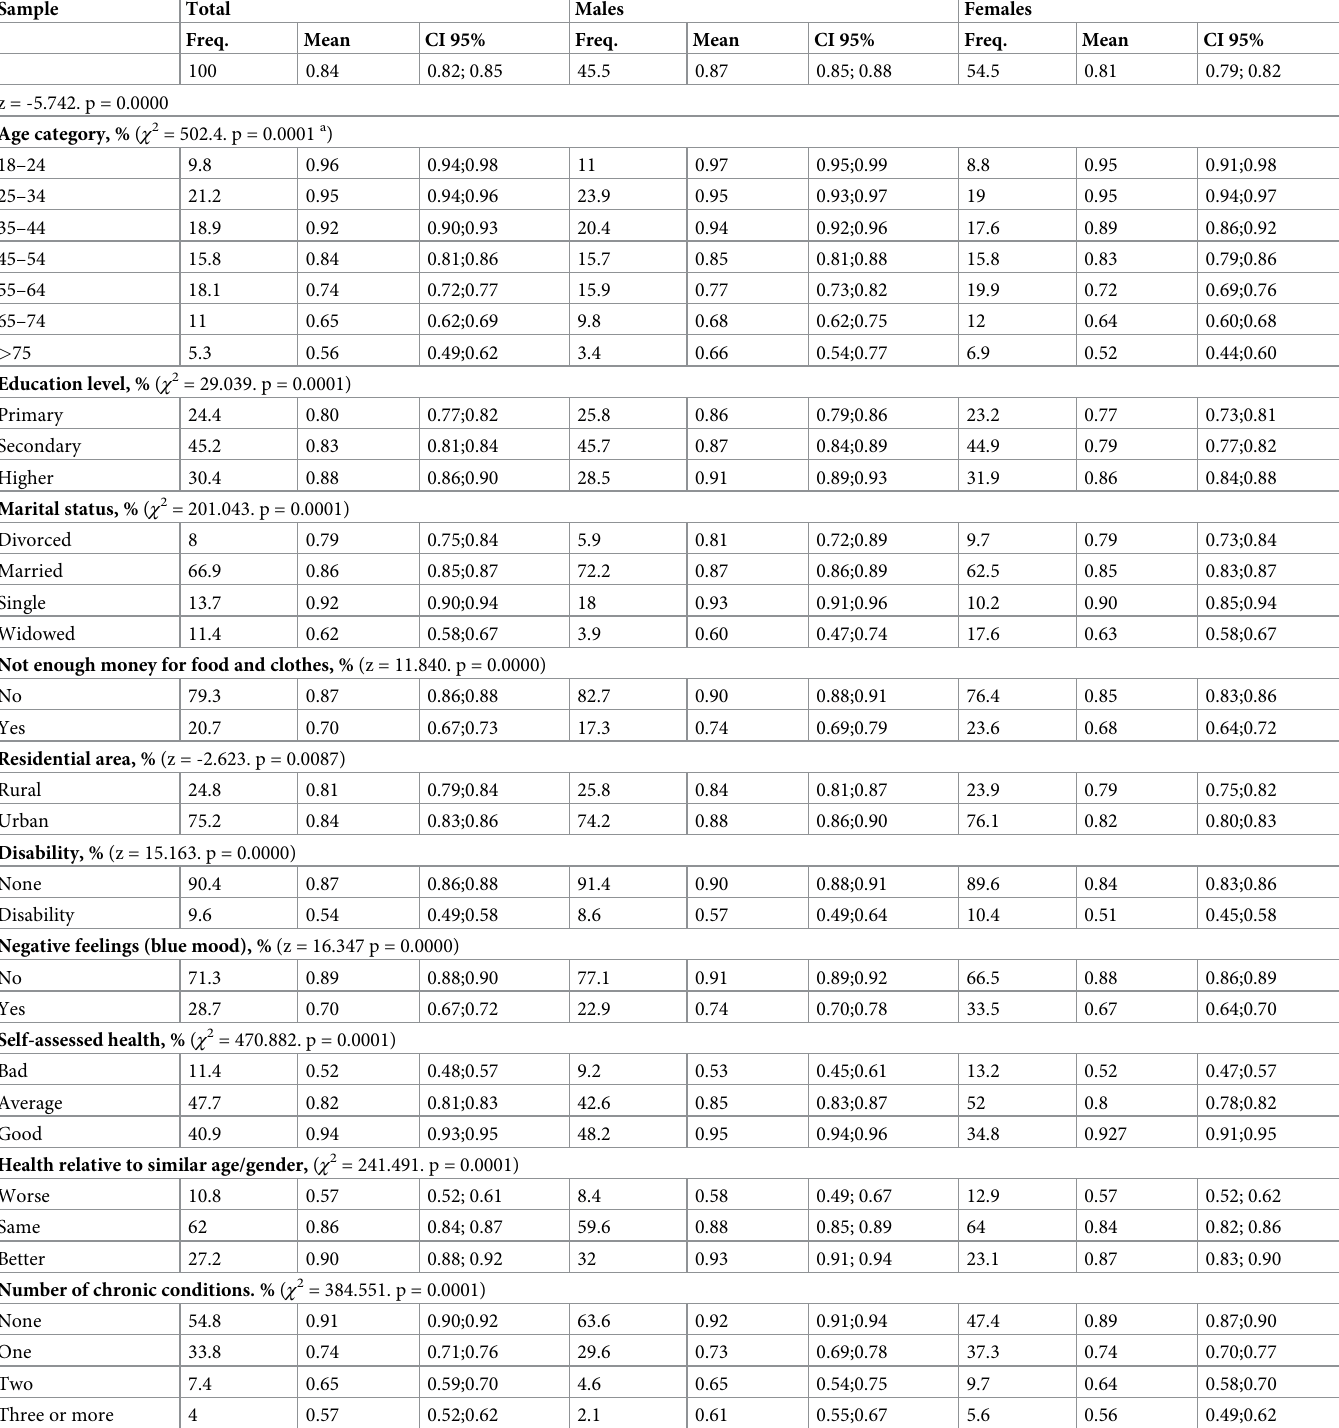
Table 3. Mean EQ–5D index by different characteristics.